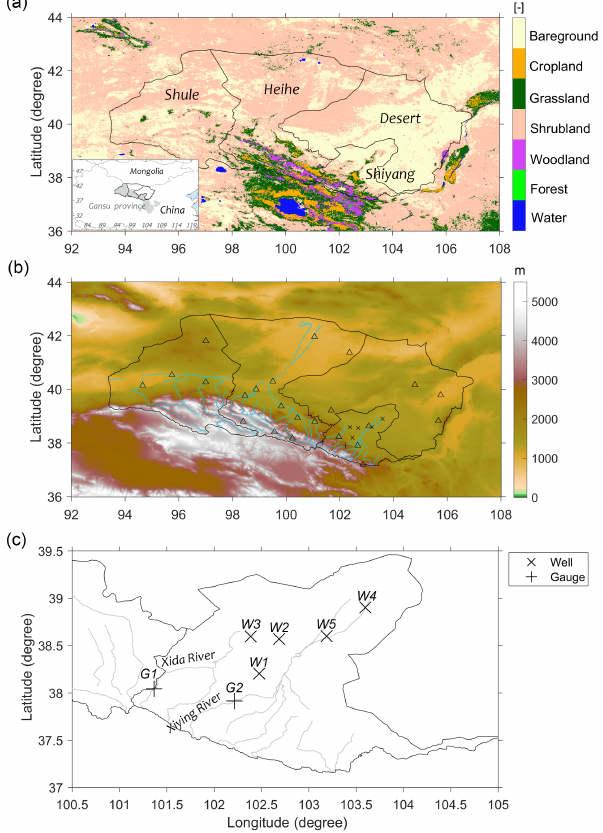
Figure 1. Geography of the Hexi Corridor. (a) Land cover and di- vision into individual regions (Shiyang River basin, Heihe River basin, Shule River basin, and a desert), (b) topography and loca- tions of the local meteorological stations (triangles), (c) zoom-in on the Shiyang River basin, showing the locations of considered groundwater wells ( × ) and river stream gauges ( +